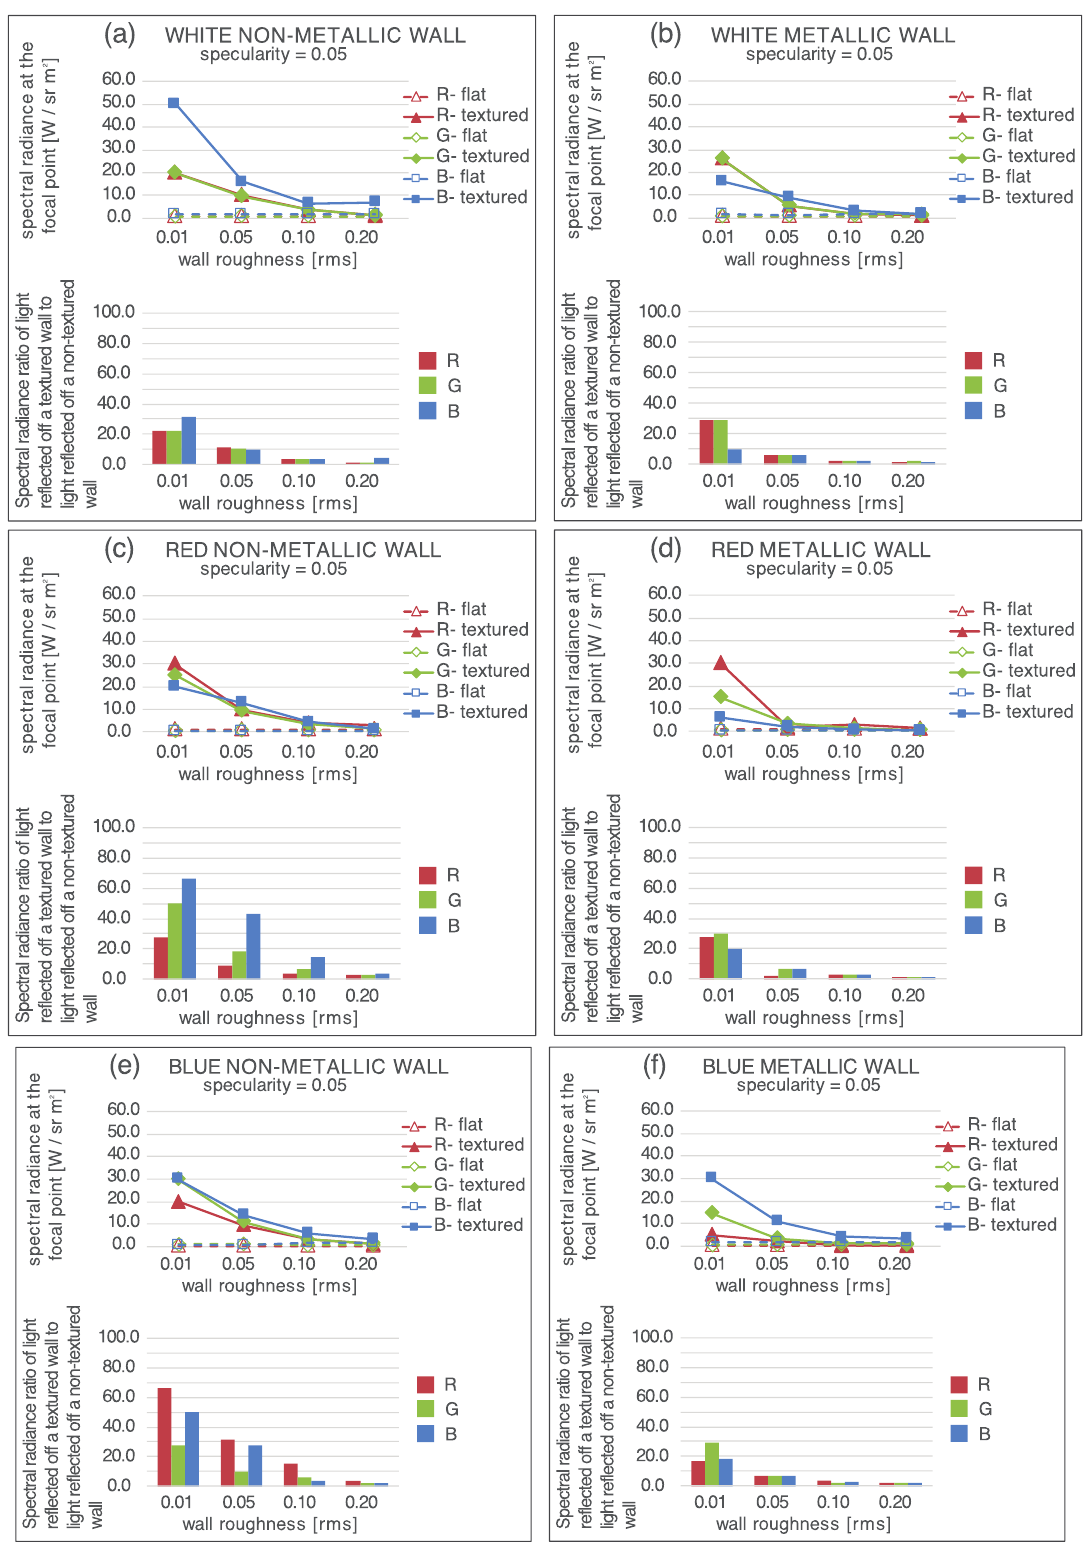
Figure 7. Spectral radiance values and spectral radiance ratios of light reflected off a textured active wall to light reflected off a non-textured active wall with a 0.05 specularity and a 0.01–0.20 range roughness.